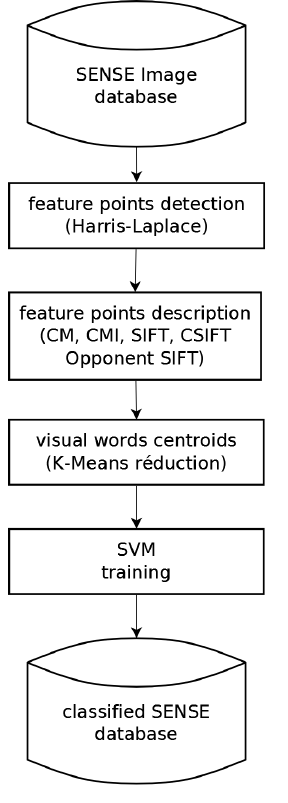
Figure 9. Emotional classifiers training